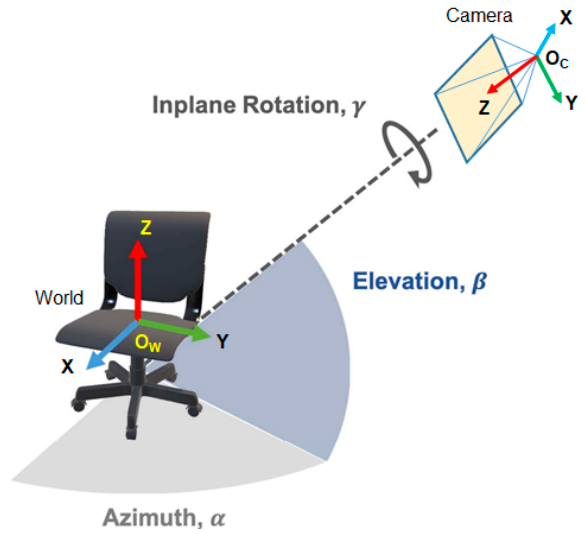
Figure 3. Rotation pose representation between the ShapeNet and the RGB camera coordinates.